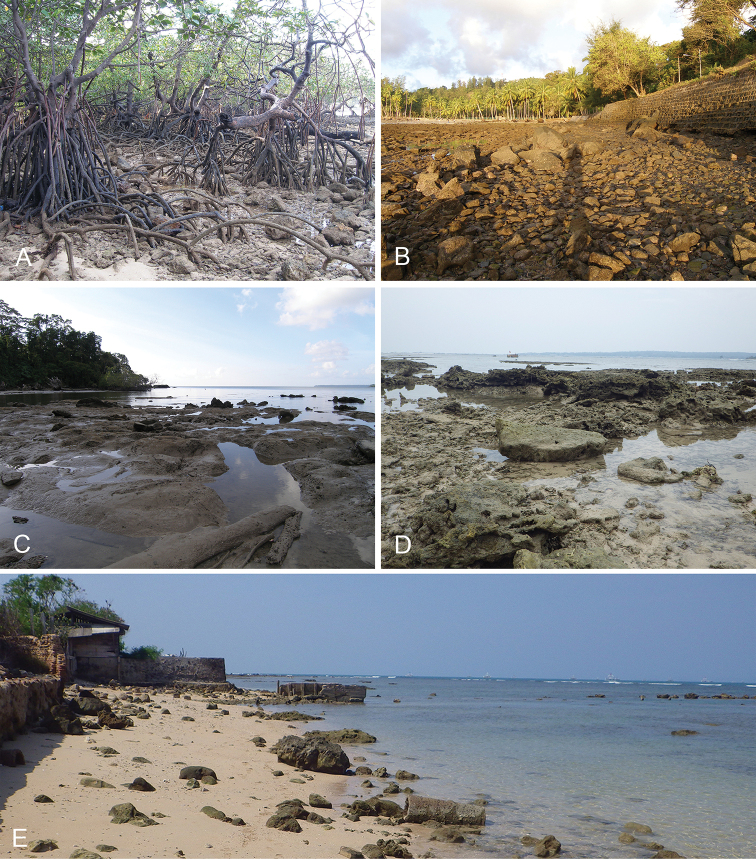
Habitats, Peronia
verruculata (unit #2) A India, South Andaman, rocky shore with a patch of Rhizophora, sand and coral rubble but no mud (st 53) B India, South Andaman, rocky shore only, no mangrove (st 54) C India, South Andaman, sandy beach with coral rubble (st 53) D Indonesia, Sumatra, coral rubble on beach exposed to estuary (st 78) E Indonesia, Sumatra, beach with a few rocks (st 82).